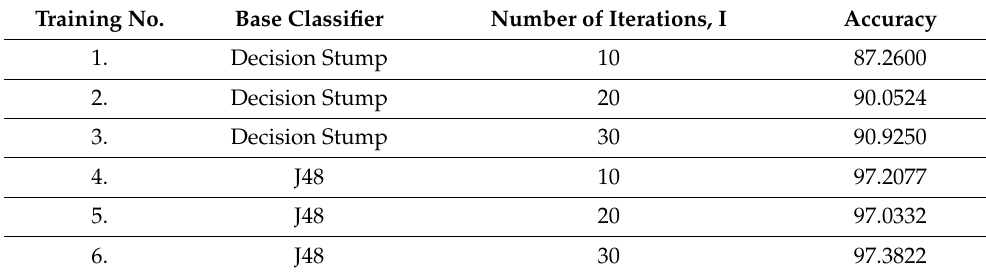
Table 11. Prediction accuracy of Adaboost M1 hyperparameter optimization. Training No.